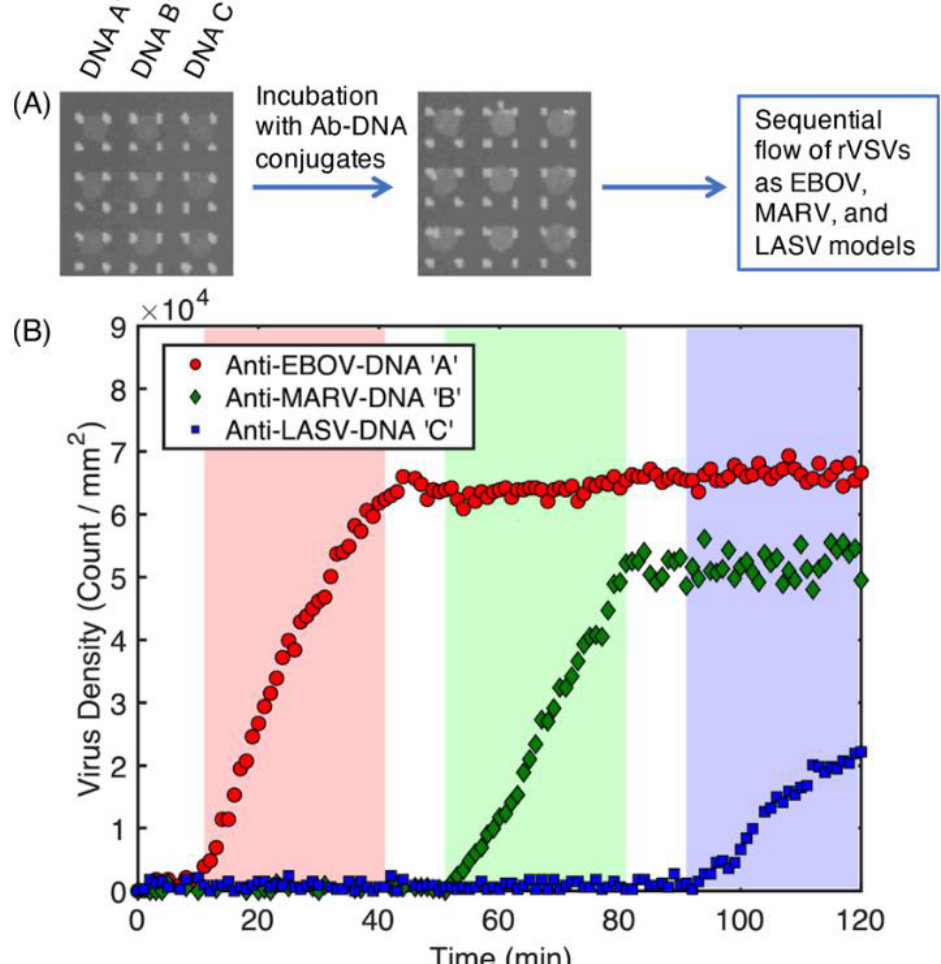
Figure 7. Multiplexed and real-time virus detection with SP-IRIS on a chip designed with DNA conjugated antibodies. ( A ) The SP-IRIS chip surface spotted with three different DNA sequences and incubation with DNA conjugated antibodies (anti-EBOV, anti-MARV, anti-LASV). ( B ) Virus density of each DNA conjugated antibody spots following sample flow [48]. Reproduced with permission from E. Seymour, N.L. Ünlü, E.P. Carter, J.H. Connor, M.S. Ünlü, ACS Sensor; Published by American Chemical Society, 2021.